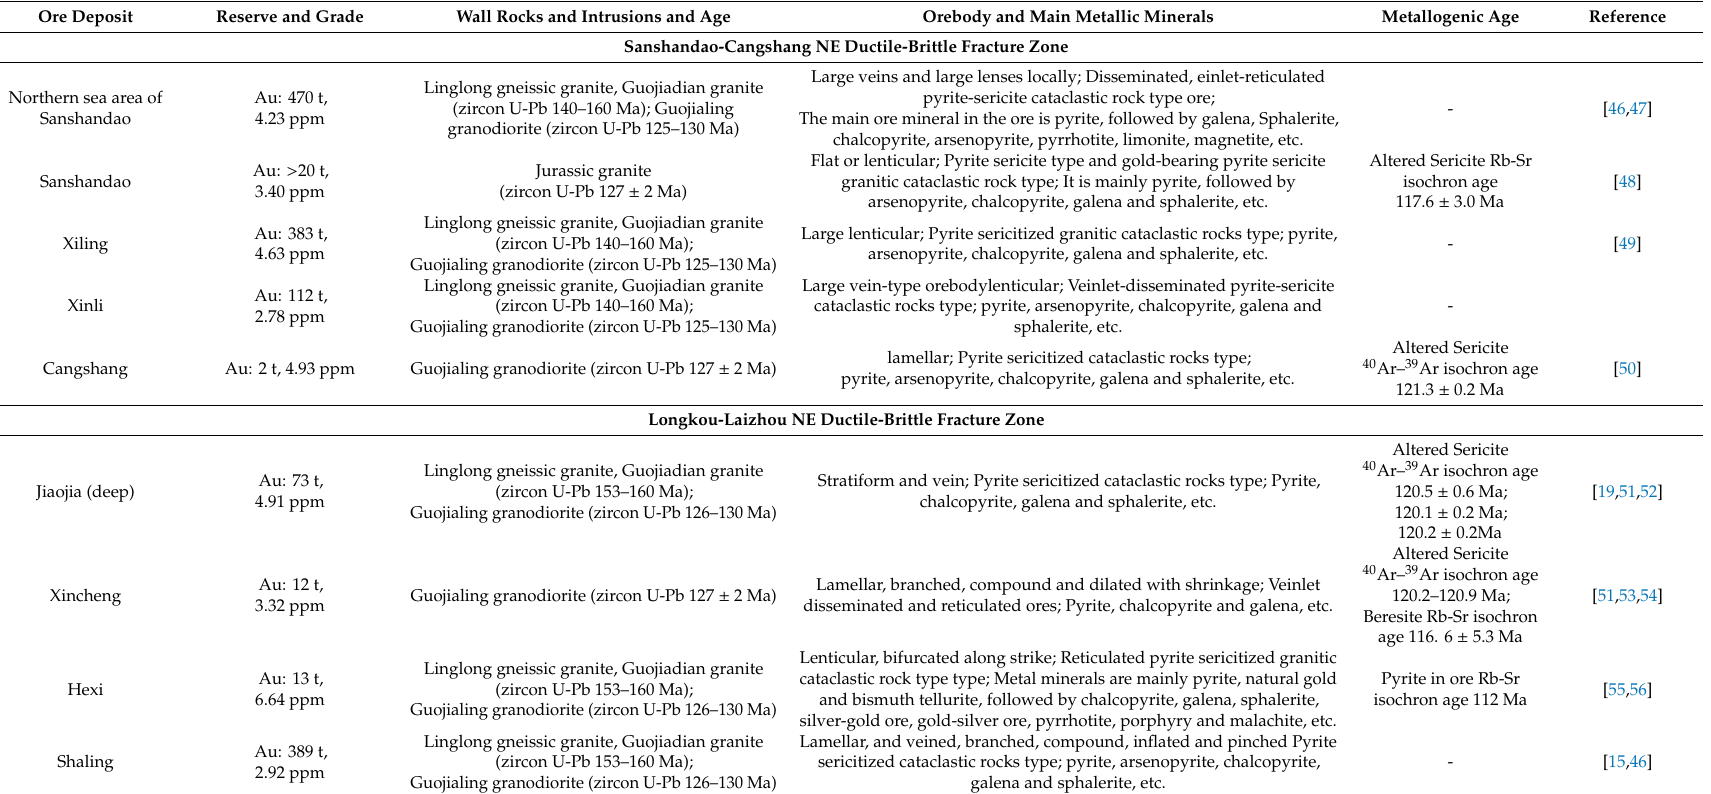
Table 1. Geological characteristics and metallogenic ages of typical Au deposits in northwestern